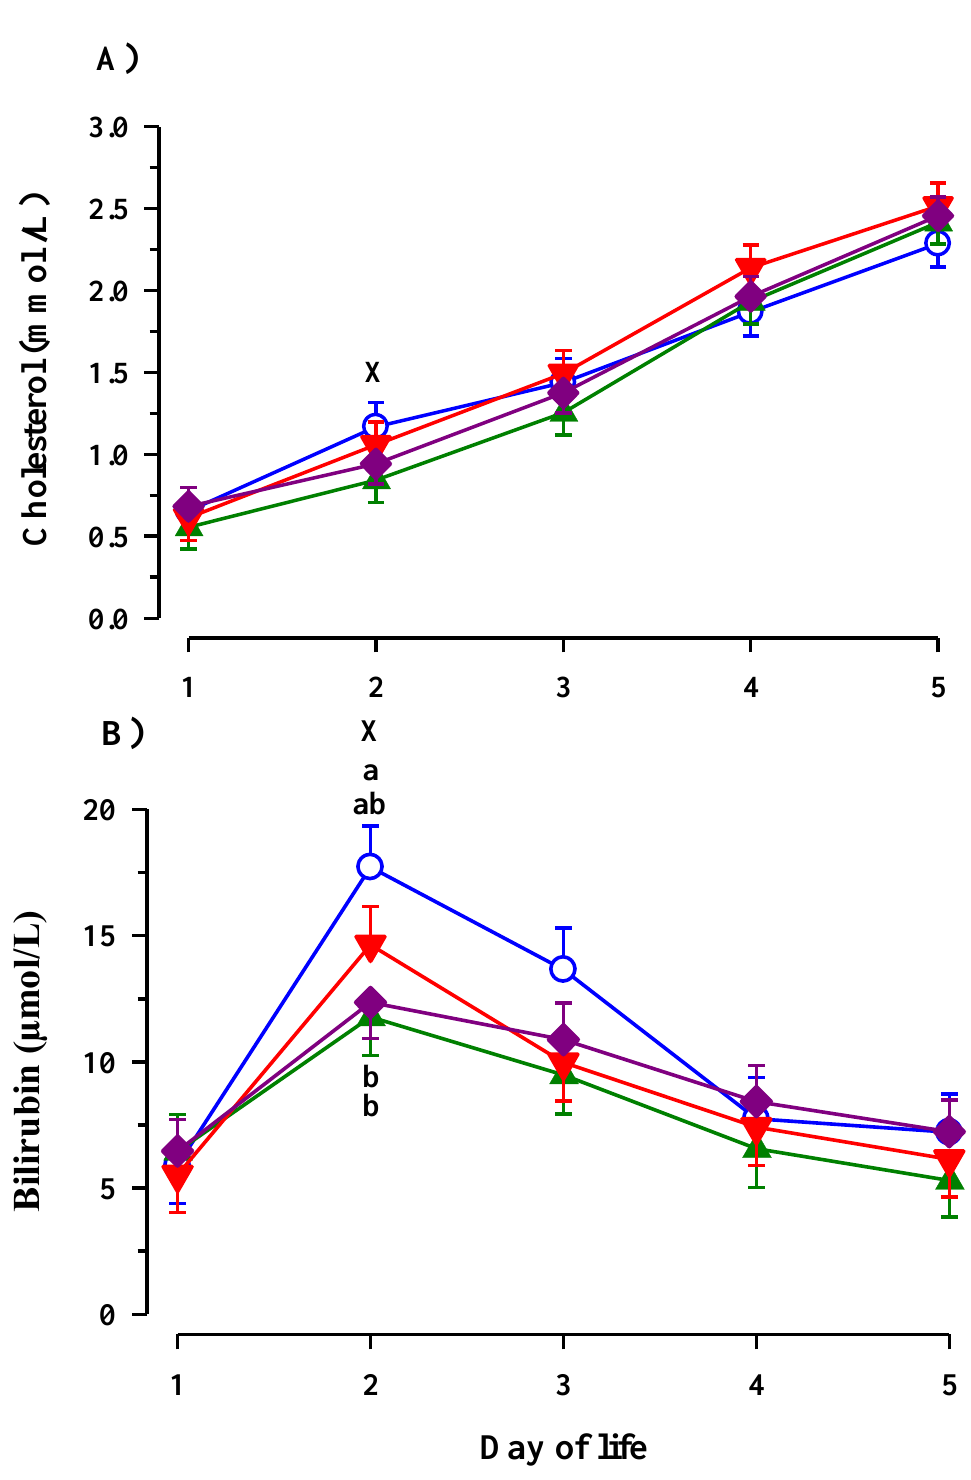
Figure 3. Plasma cholesterol ( A ) and bilirubin ( B ) concentration in calves dependent on maternal fatty acid supplementation ( ○ control, CON n = 9; ▲ EFA, essential fatty acids, n = 9; ▼ , CLA, conjugated linoleic acid, n = 9; ♦ , EFA + CLA, n = 11) and time after birth. Day 1 corresponded to the day of birth. ab Different superscripts mark significant differences between groups at similar time points ( p < 0.05). X designates significant differences between calves with maternal EFA supplementation and without maternal EFA supplementation within a time point ( p <